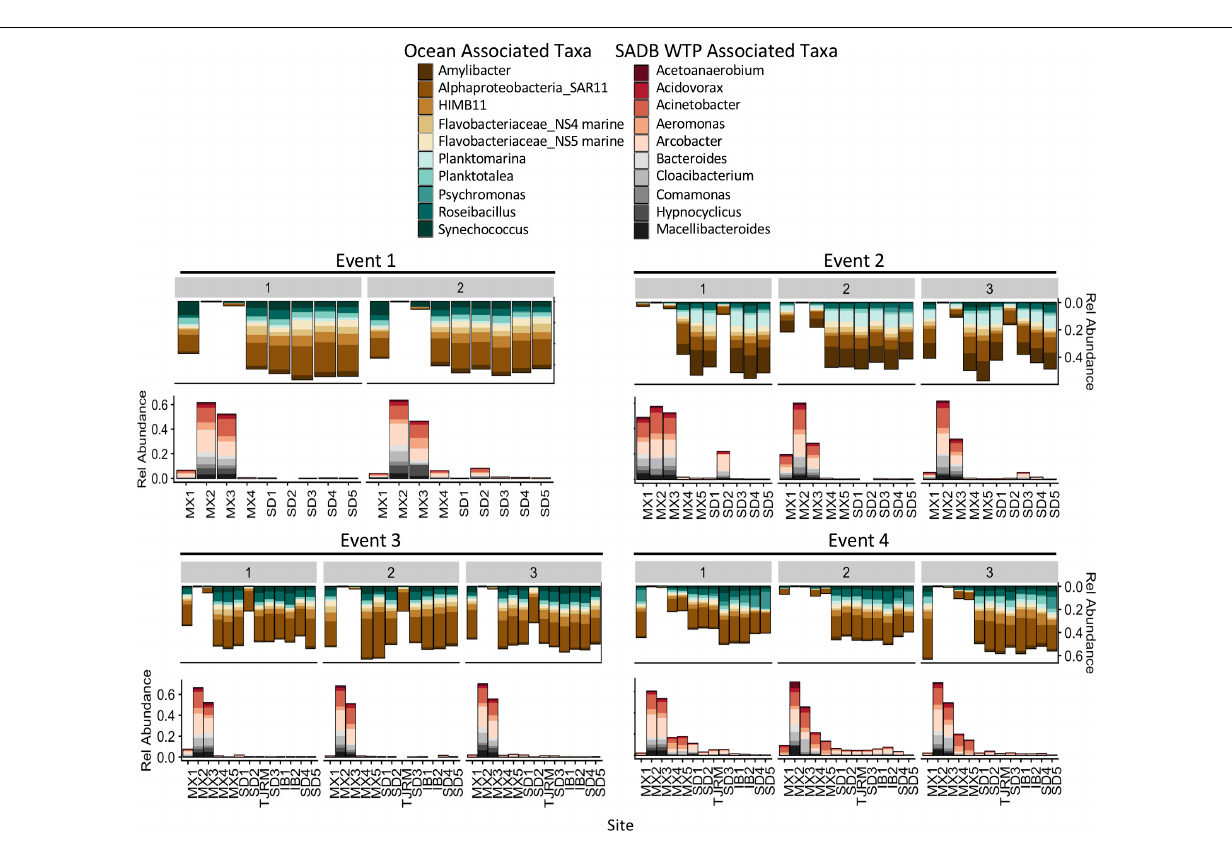
Frontiers in Microbiology |